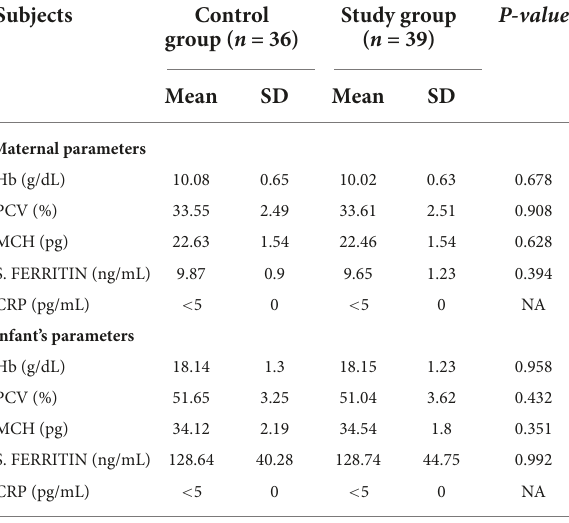
TABLE 2 Baseline hematological parameters of mothers and infants at recruitment.